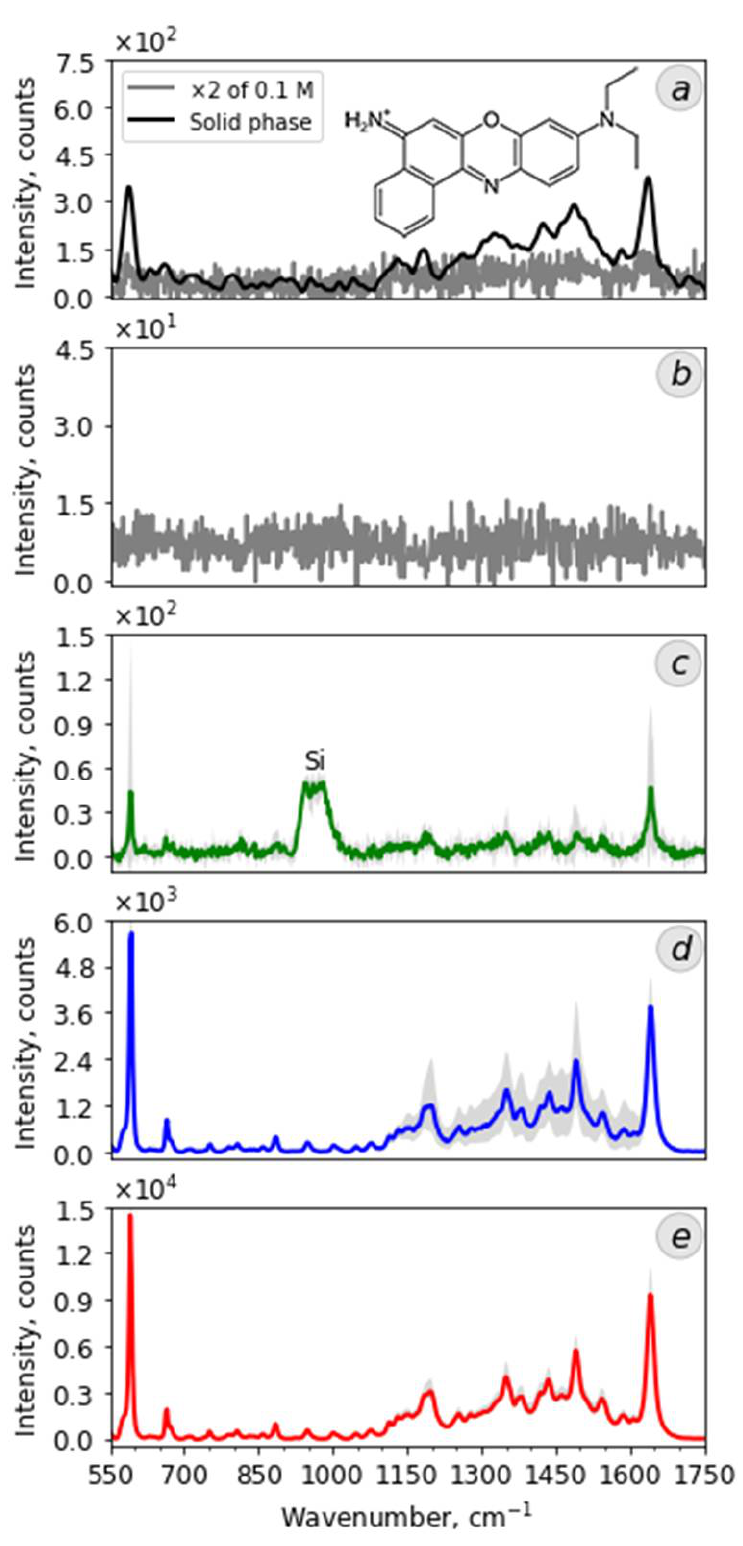
Figure 5. Raman spectra of NB (( a )—solid phase and 0.1 M, ( b )—10 − 6 M) and SERS ( c – e ) spectra of NB with a concentration of 10 − 6 M, obtained on the surface of silver nanostructures (( c ), crystallites; ( d ), "sunflowers"; ( e ), dendrites) in the pores of the SiO 2 /Si template.